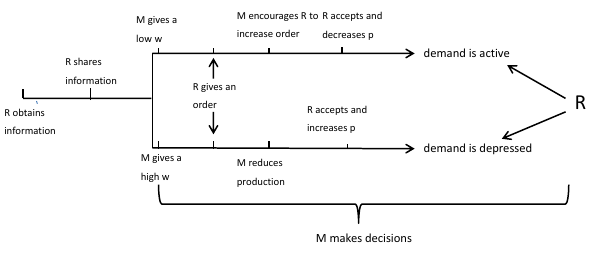
Figure 1. The cooperative case.